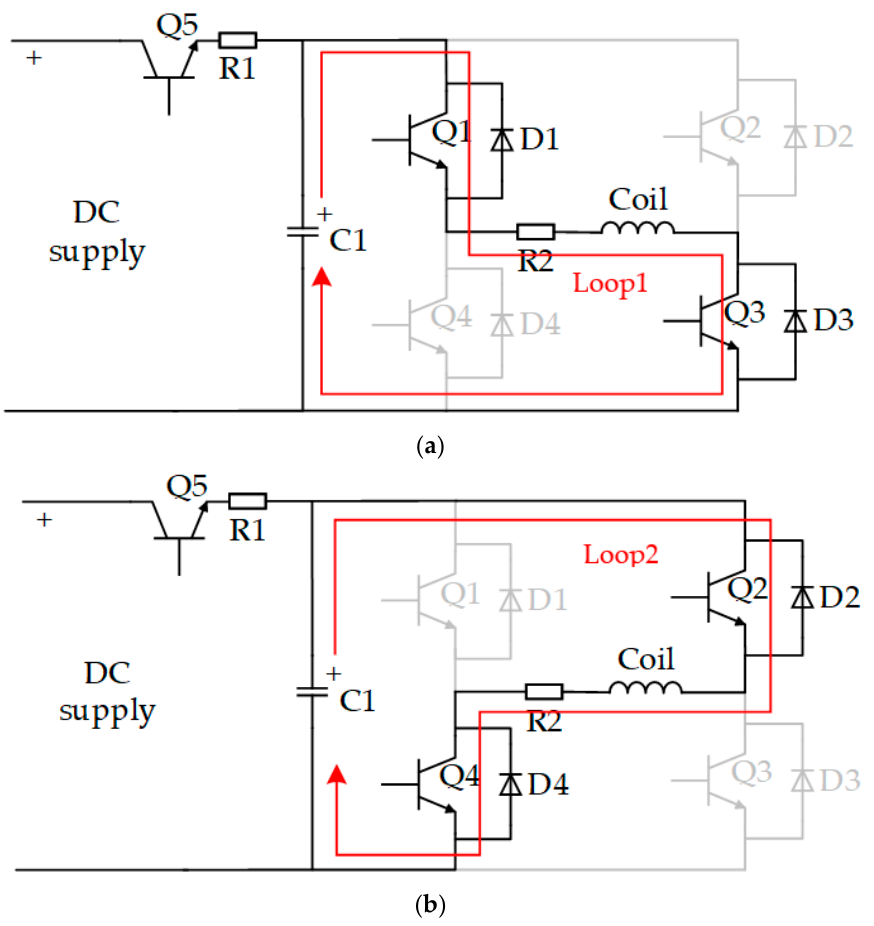
Figure 8. Control principle. ( a ) Making procedure. ( b ) Breaking procedure.